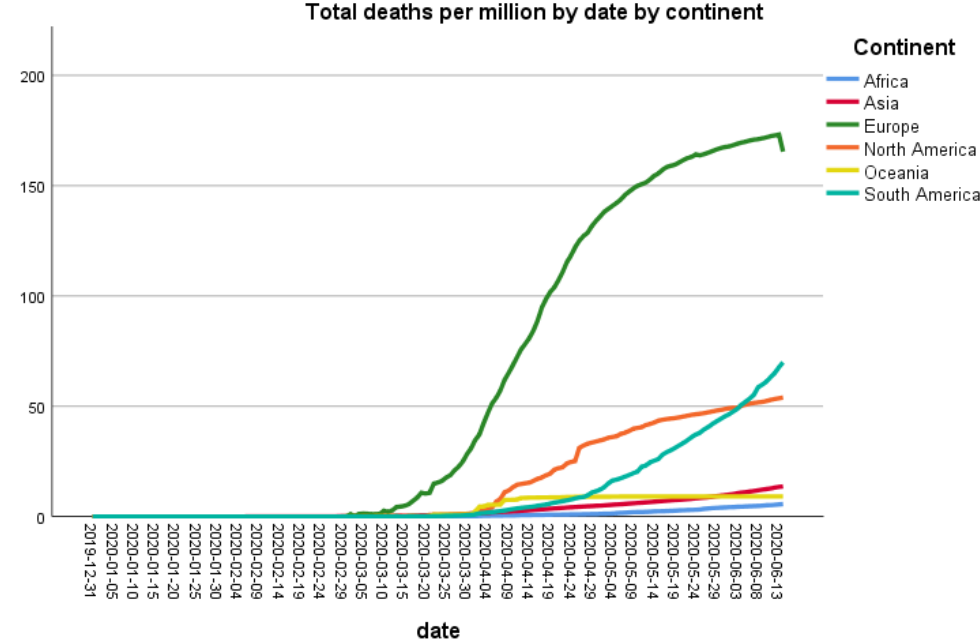
Figure 2. Trend of cumulative new deaths standardized for population (per million) by continent.